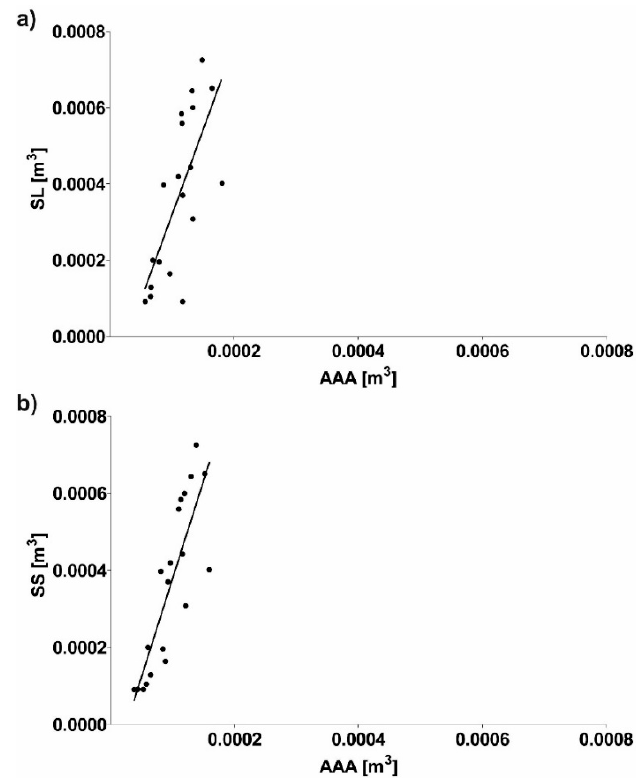
Figure 6. Scatterplot graphic representation of Pearson’s correlation factors rho [-] for the analyzed ( a ) SL in function of AAA (rho = 0.7402), ( b ) SS in function of AAA (rho = 0.8401). For all analyzes p < 0.002.